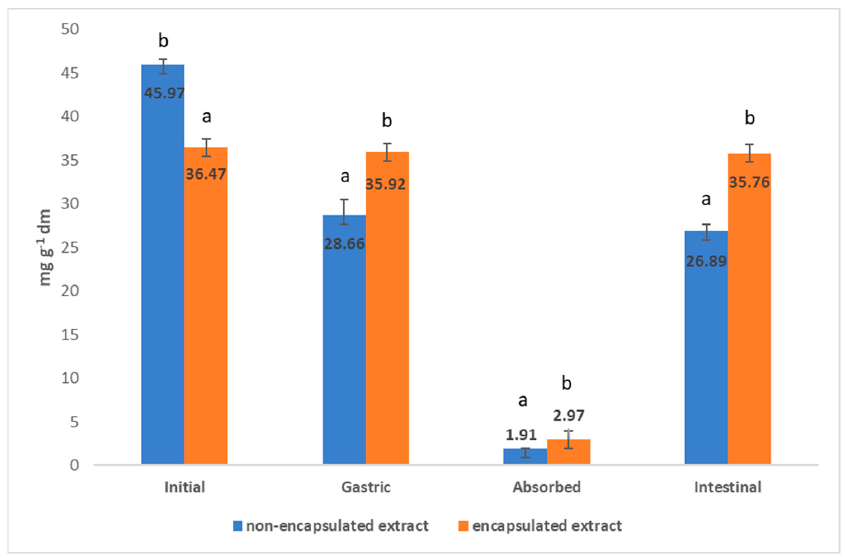
Figure 3. Comparison of the in vitro bioavailability of non-encapsulated extract and encapsulated extract with best properties. Values with different letters within phases are statistically different at p < 0.05. Table 4. Polyphenolic profile including mass spectrometric data and concentration of identified in- dividual compounds of nettle leaves extract powder with the highest encapsulation capacity.